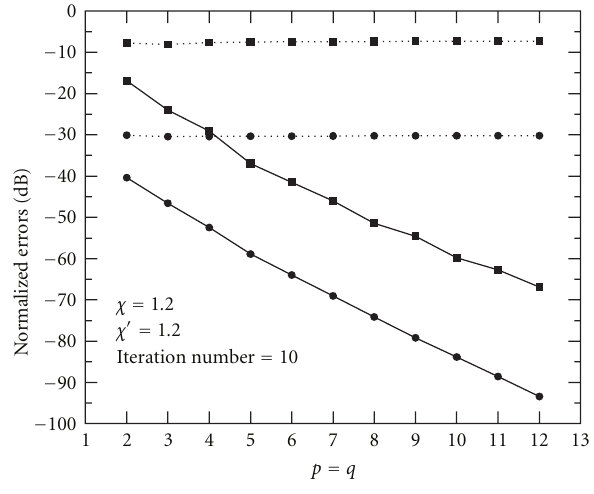
Figure 6: Normalized maximum ( (cid:2) ) and mean-square ( ) errors in the reconstruction of the NF data needed for the NF-FF transformation. Dotted lines: when using the nonuniform samples. Solid lines: when using the recovered helicoidal uniform samples.